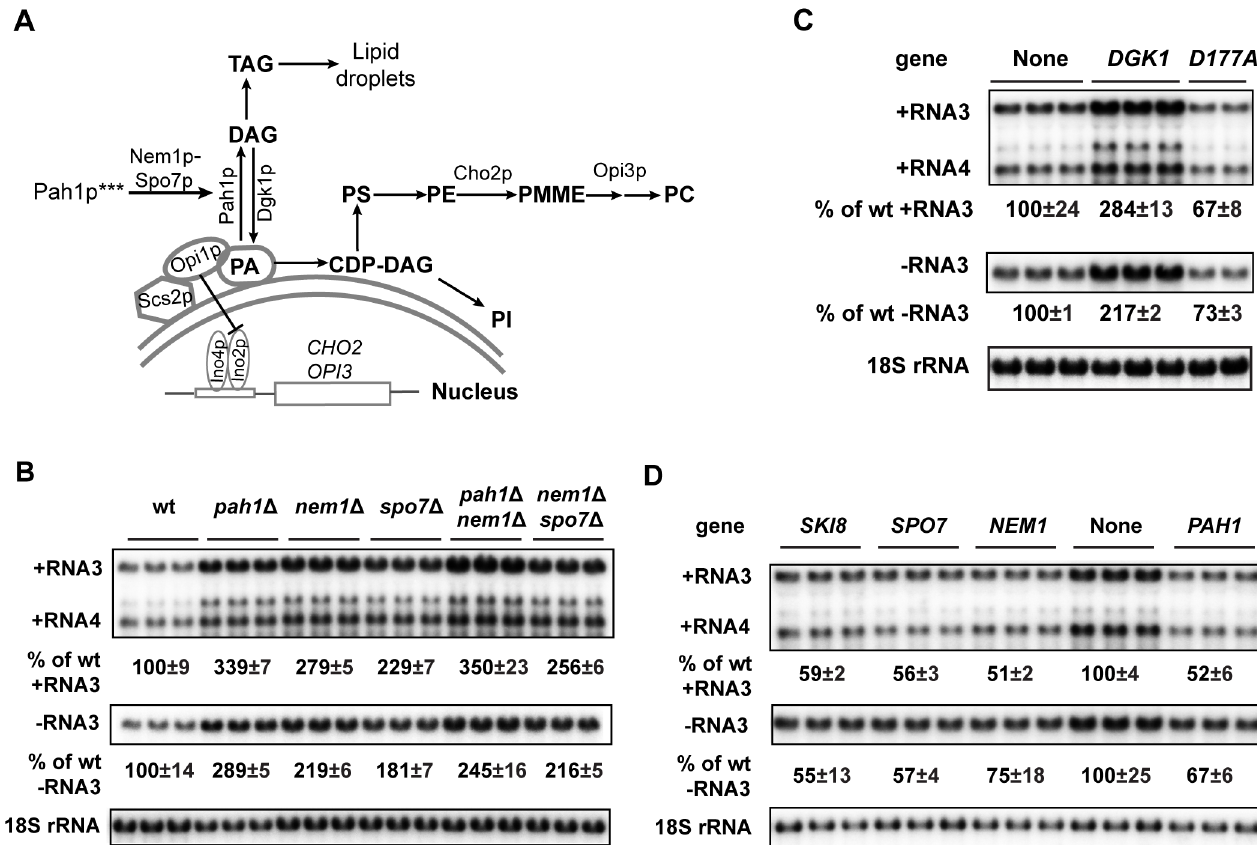
Fig 1. The inactivation or disruption of Pah1p promotes BMV genomic replication. (A) Diagram of lipid metabolism in yeast. Key enzymes are shown. PA serves as a substrate for phospholipids and TAG. PA and Scs2p bind to and sequester Opi1p, keeping it from reaching to the nucleus, where Opi1p interacts with Ino2p and represses transcription of CHO2 , OPI3 and other genes involved in phospholipid synthesis. Pah1p (cid:3)(cid:3)(cid:3) represents the hyperphosphorylated inactive Pah1p. (B) Accumulated BMV RNAs in wt and mutant cells with PAH1 deleted or Pah1p inactivated. Positive- and negative-strand viral RNAs were detected by using BMV RNA strand-specific probes. 18S rRNA was included as a control to eliminate loading variations. All experiments shown in the figure and in subsequent figures have been repeated multiple times and a representative figure is shown. (C) BMV replication in wt cells overexpressing wt or a defective mutant D177A of Dgk1p. (D) BMV replication in wt cells overexpressing PAH1 , NEM1 , SPO7 ,or SKI8 . SKI8 ,a well-known antiviral gene, serves as a positive control.